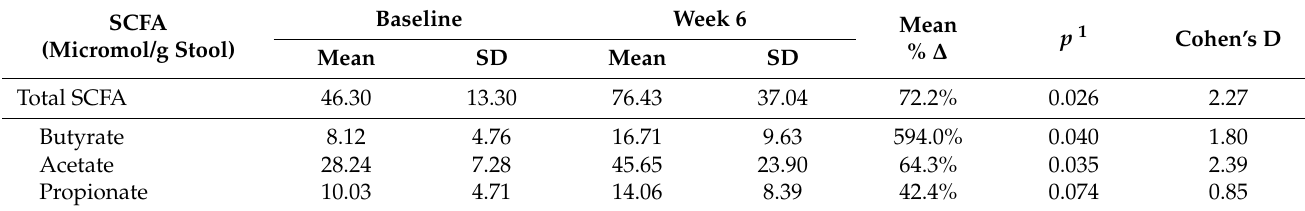
Table 6. Pilot Trial Stool Short-Chain Fatty Acids (SCFAs) Over 6 Weeks.